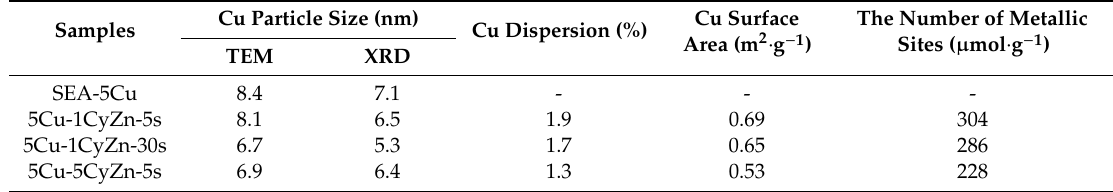
Table 3. Metallic Cu particle size, dispersion, and metallic surface area of reduced catalysts.